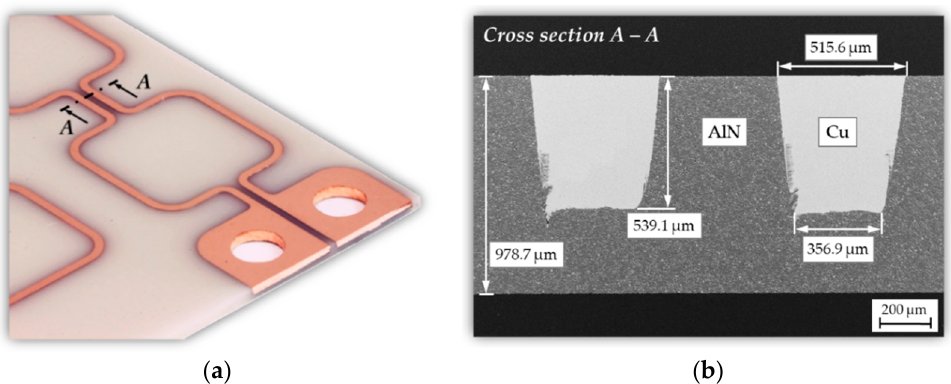
Figure 11. AlN/Cu micro coil after manufacturing process: ( a ) Photographic image of the micro coil; ( b ) SEM cross section of two copper conductor lines embedded in AlN.